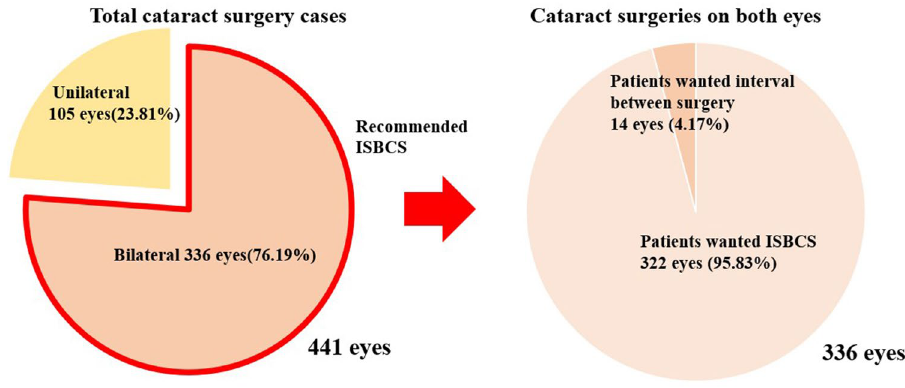
Figure 1. Distribution of cataract surgery patients. ISBCS, immediate sequential bilateral cataract surgery.